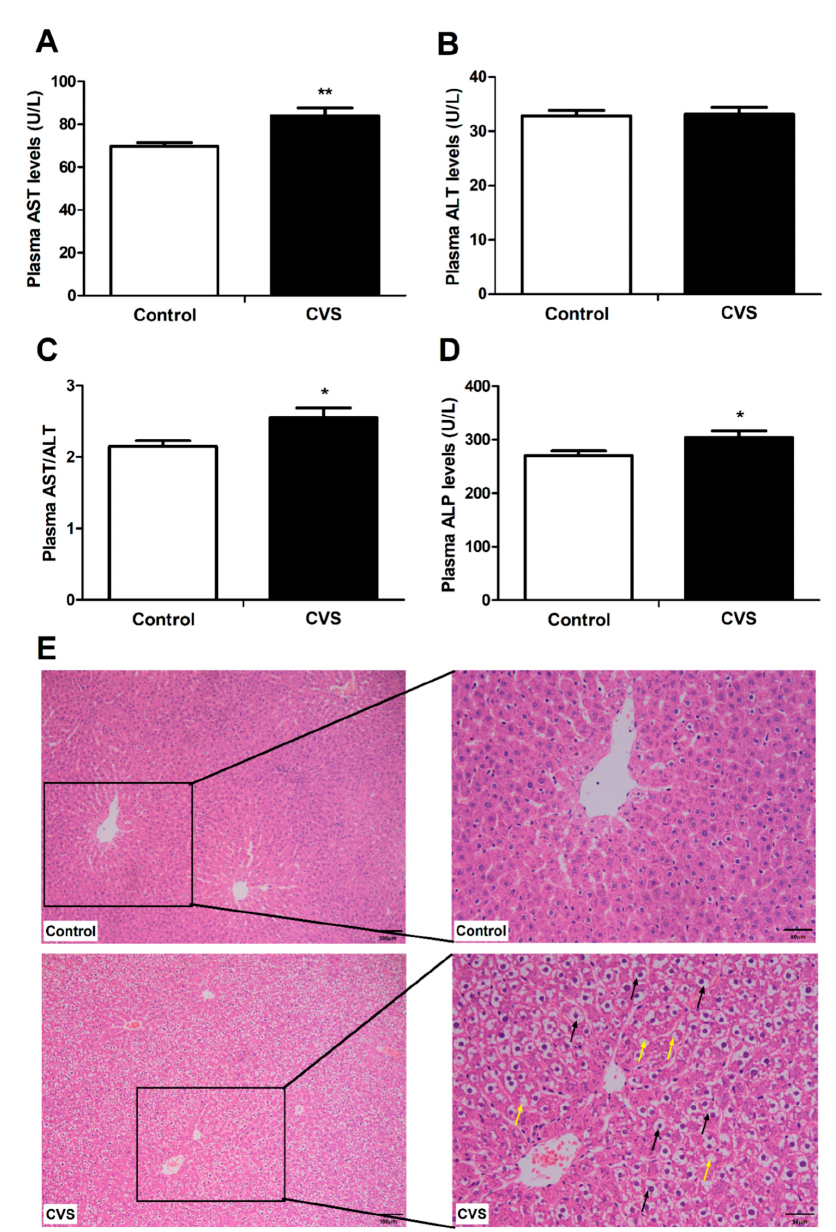
Figure 2. Effect of chronic variable stress on plasma indicators and histomorphology related to liver injury in rats. ( A – D ) Plasma AST, ALT, AST/ALT, and ALP enzyme levels were determined as described in Materials and Methods. ( E ) Hematoxylin and eosin-stained liver tissue was observed at magnifications of ×100 and ×200. Black arrows indicate hepatocyte swelling; yellow arrows indicate hepatocyte vacuolation. Con: control group; CVS: chronic variable stress roup. Values were expressed as means ± SEM; n = 12 in each group for panels A − D ; n = 3 in each group for panel E. * p < 0.05, ** p < 0.01.